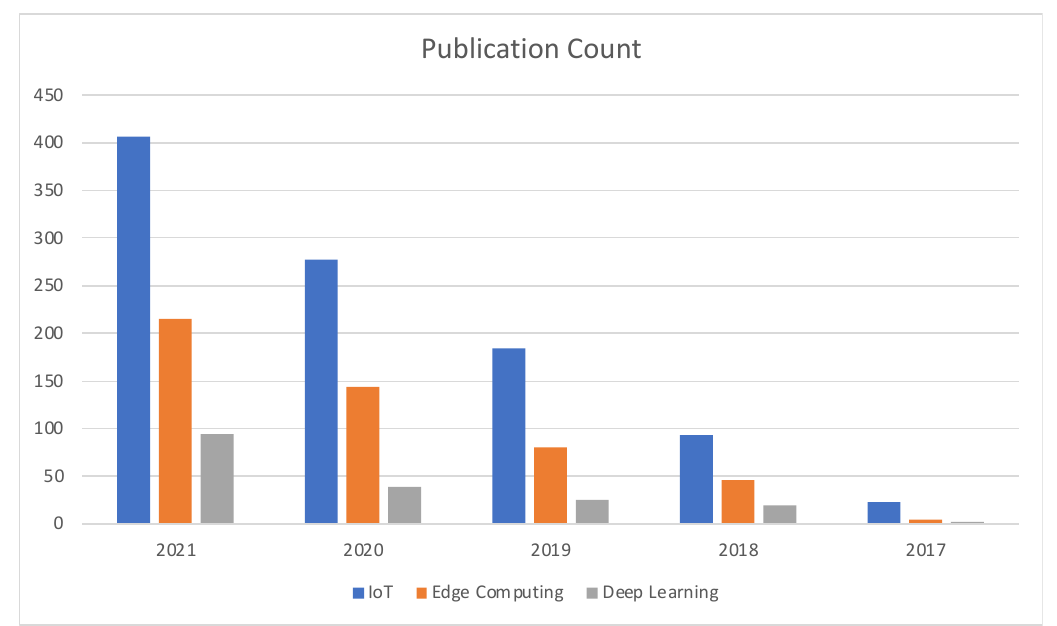
Figure 16. Year-specific Publication Count comparison among Allied Technologies.